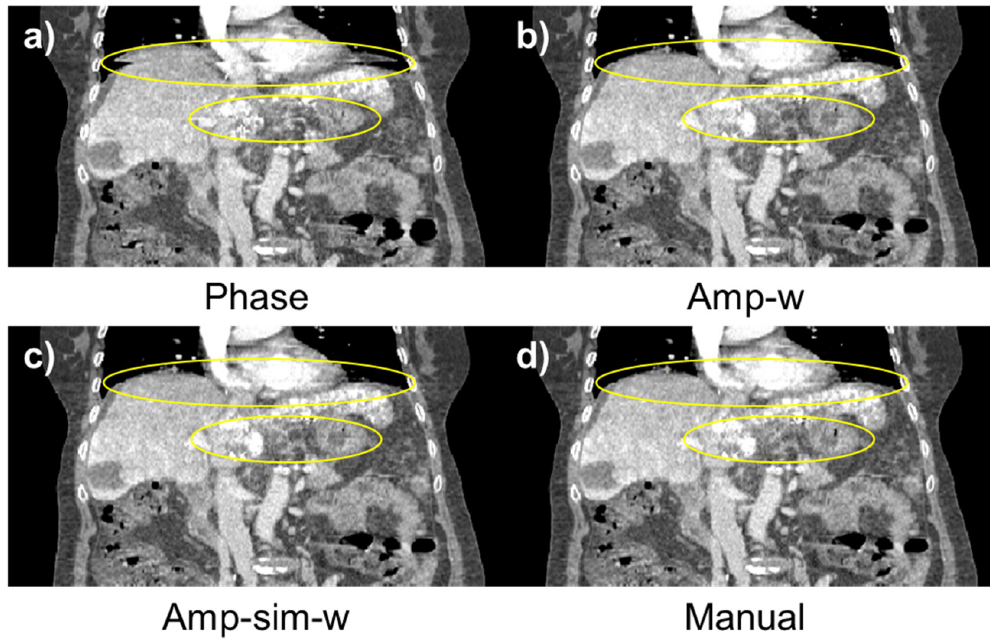
Fig 13. Coronal view of sorted 4DCT of the abdominal region according to the sorting algorithm. (Patient #33) a) conventional phase sorting, b) amplitude-weighted phase sorting, c) amplitude-weighted phase sorting with image similarity, and d) manual sorting